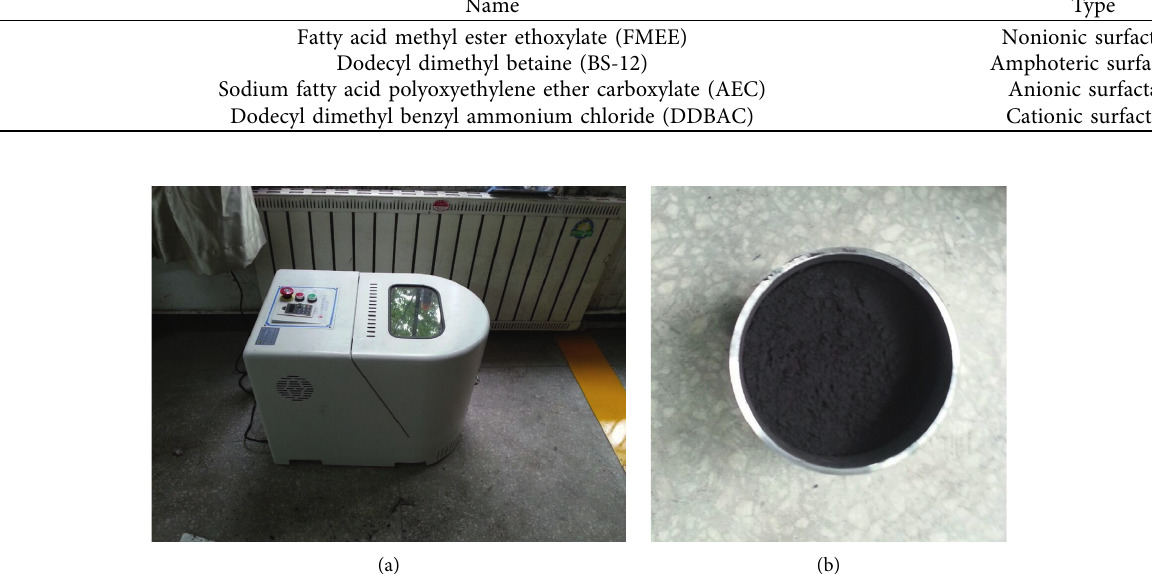
Figure 1: Preparation process of pulverized coal: (a) planetary ball mill; (b) pulverized coal and ball mill.